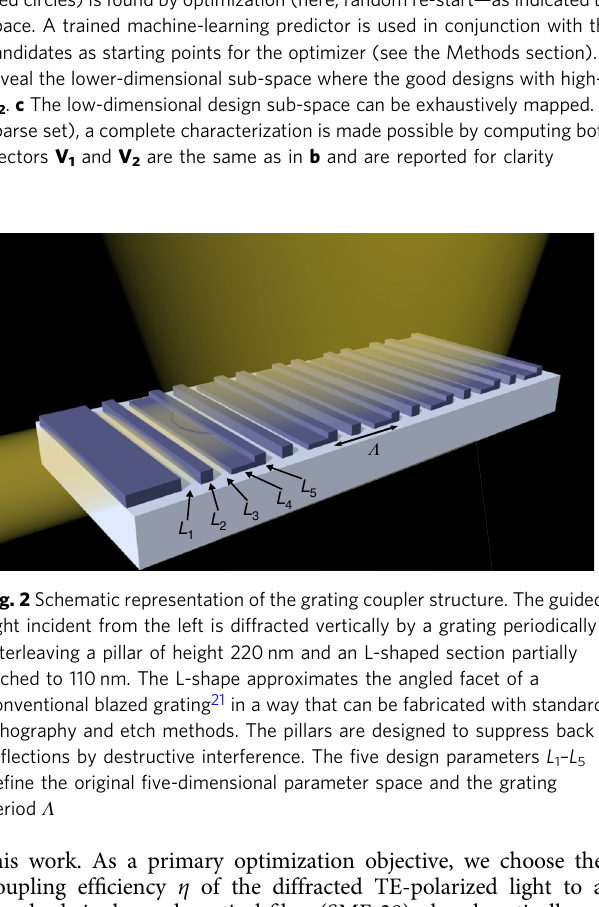
The optimization is guided by a single performance metric, the coupling ef fi ciency η . Only solutions with η larger than 0.74 are retained, de fi ned here as good designs. Back re fl ection r is not